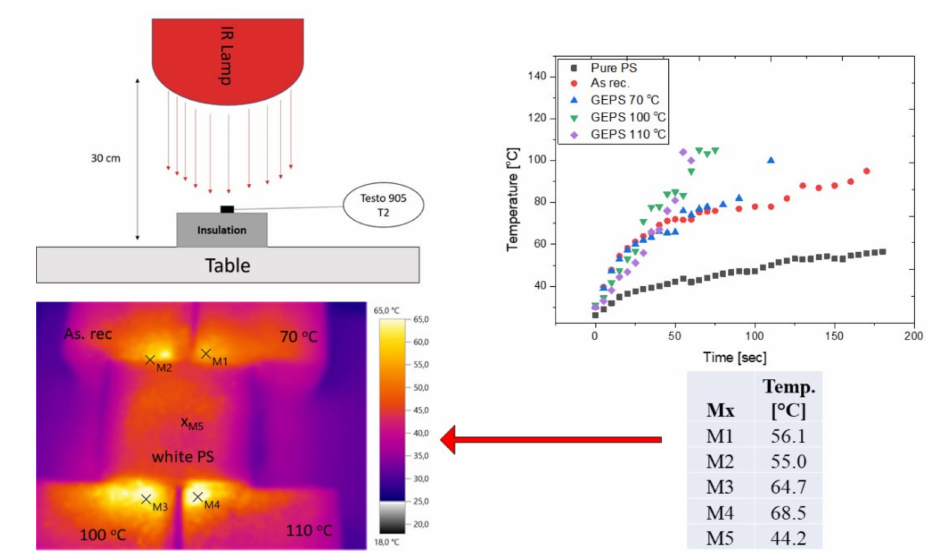
Figure 12. IR absorption